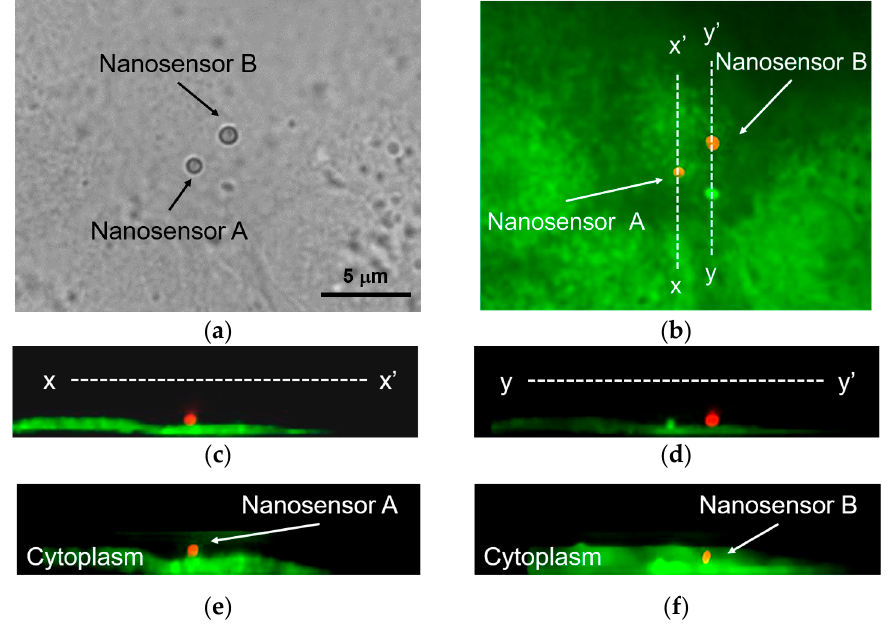
Figure 8. Injection of the immobilized sensor by local laser heating. ( a ) Optical image of the nanosensors on an MDCK cell; ( b ) Fluorescence image before injection (red is the nanosensor, bright green is fluorescence from the cell); ( c ) Cross-sectional view of nanosensor A before laser irradiation (x-x’); ( d ) Cross-sectional view of nanosensor B before laser irradiation (y-y’); ( e ) Cross-sectional view of nanosensor A after laser irradiation; ( f ) Cross-sectional view of nanosensor B after laser irradiation.